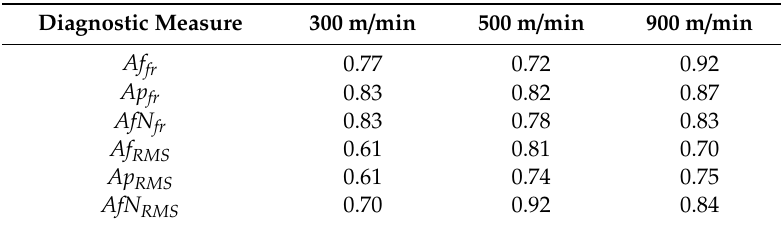
Figure 5. Diagnostic measures of vibration acceleration’s in: ( a ) frequency domain, v c = 300 m/min; ( b ) time domain, v c = 500 m/min; and ( c ) frequency domain, v c = 900 m/min; as a function of tool wear. Table 9. Values of coe ffi cient R 2 based on vibration acceleration. Table 9. Values of coefficient R 2 based on vibration acceleration.